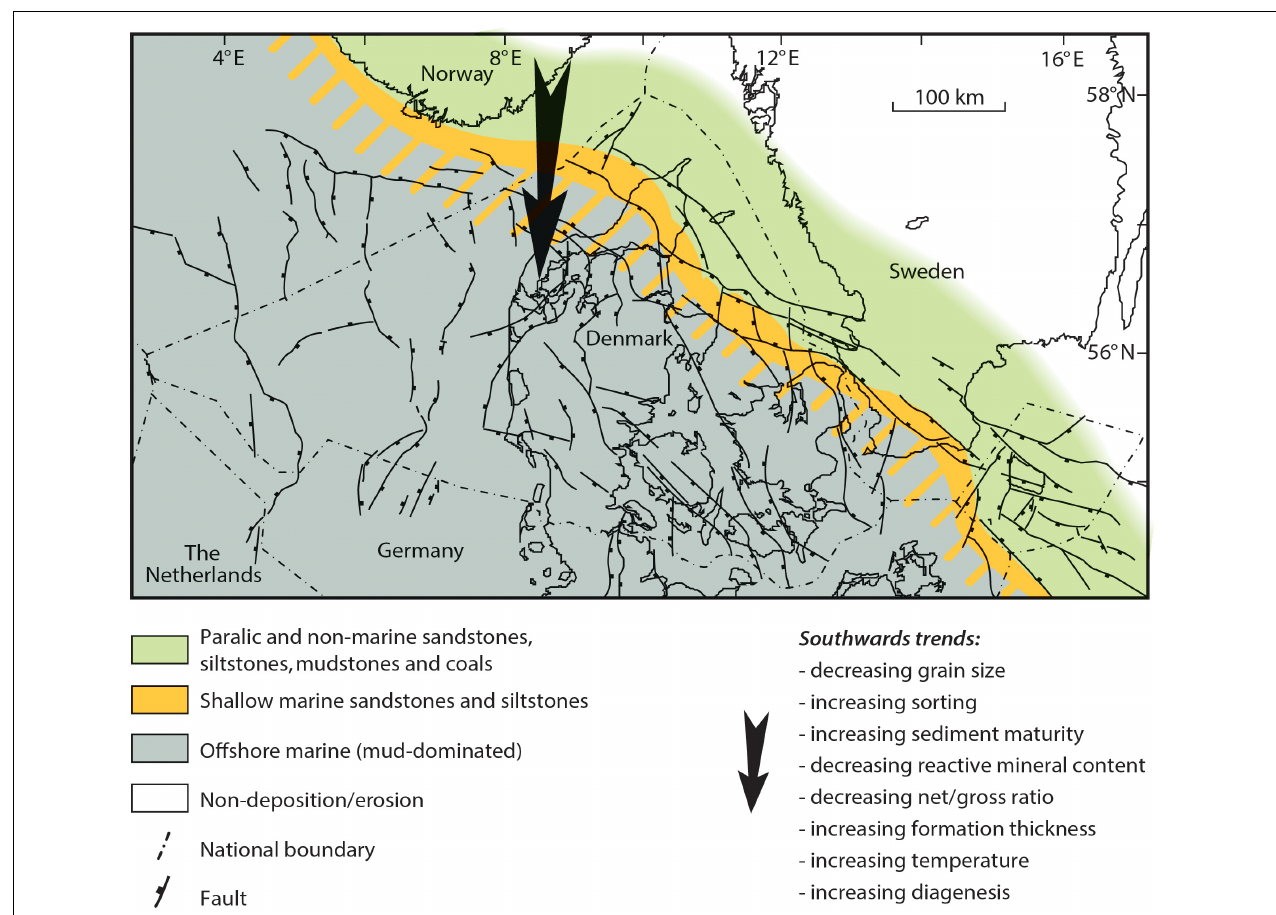
FIGURE 14 | Hettangian paleogeography from Michelsen et al. (2003) corresponding to the time when the upper part of the Gassum Formation was deposited. The facies belts shifted back and forth corresponding to repeated sea-level changes. The observed directional trends that influence the reservoir quality in the study area are